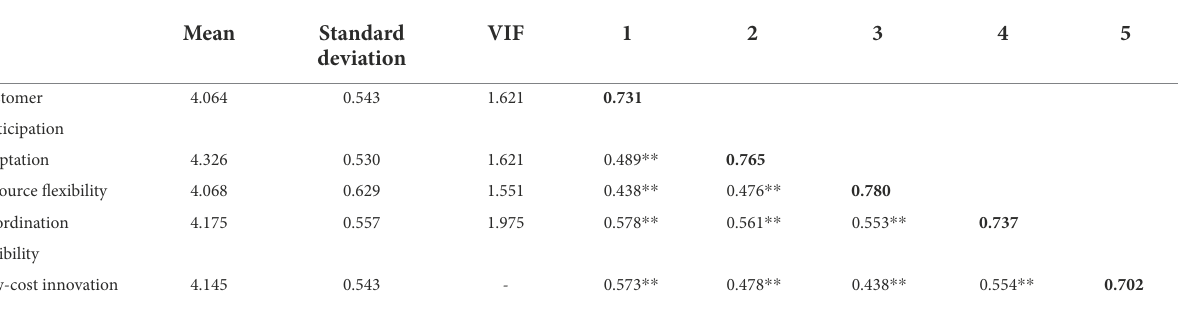
TABLE 2 Means, standard deviations, and correlation